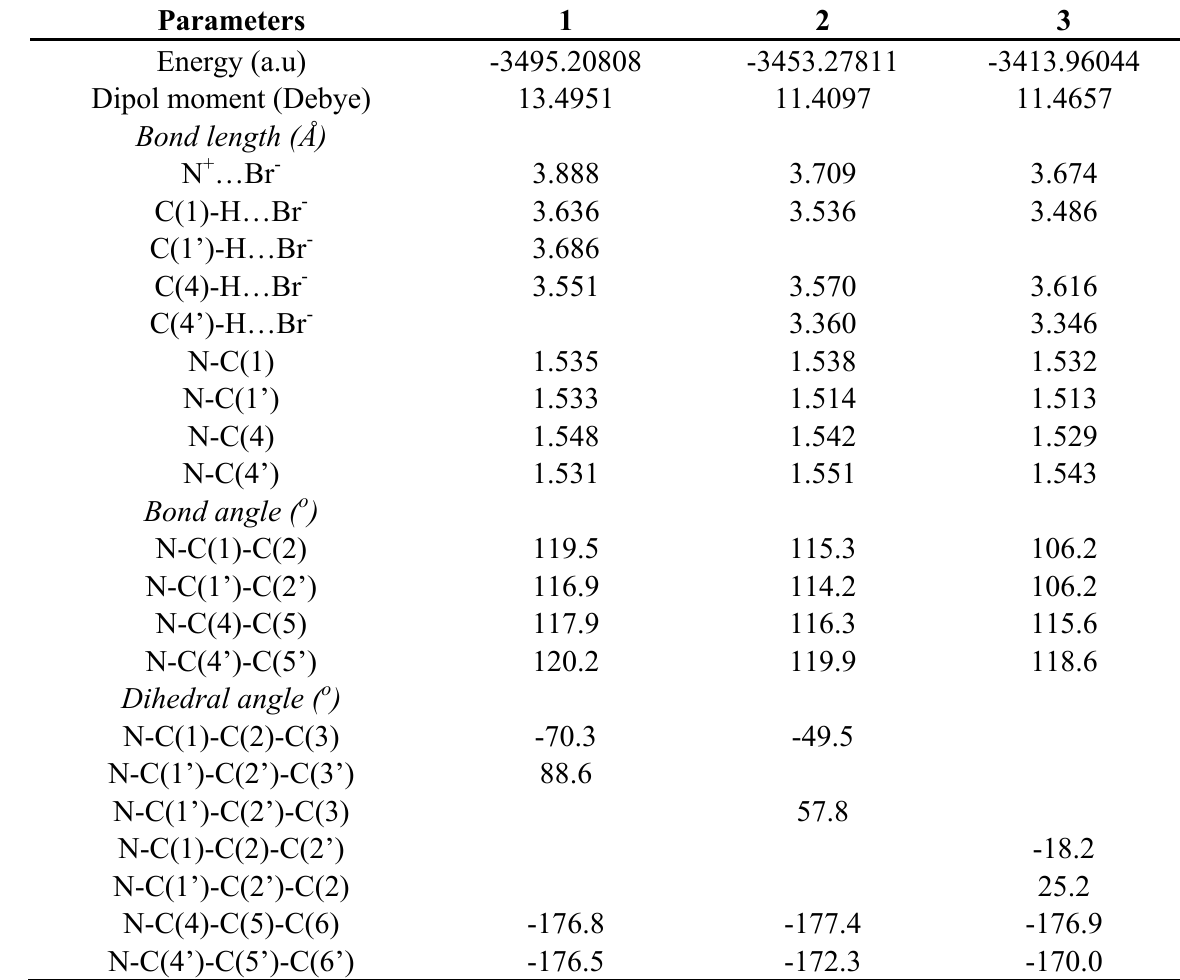
Table 1. Selected parameters of investigated molecules 1-3 estimated by B3LYP/6- 31G(d,p) calculations.